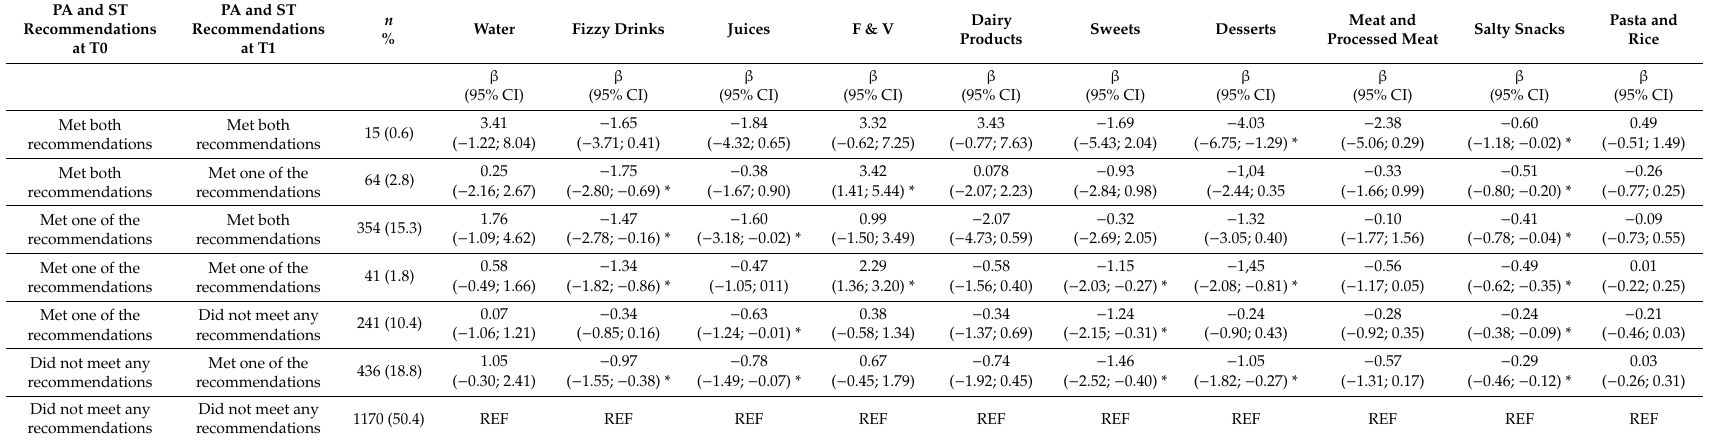
Table 3. Results of the lineal mixed e ff ects model between food consumption and adherence to physical activity and screen time recommendations at baseline (T0) and follow-up (T1) periods ( n =